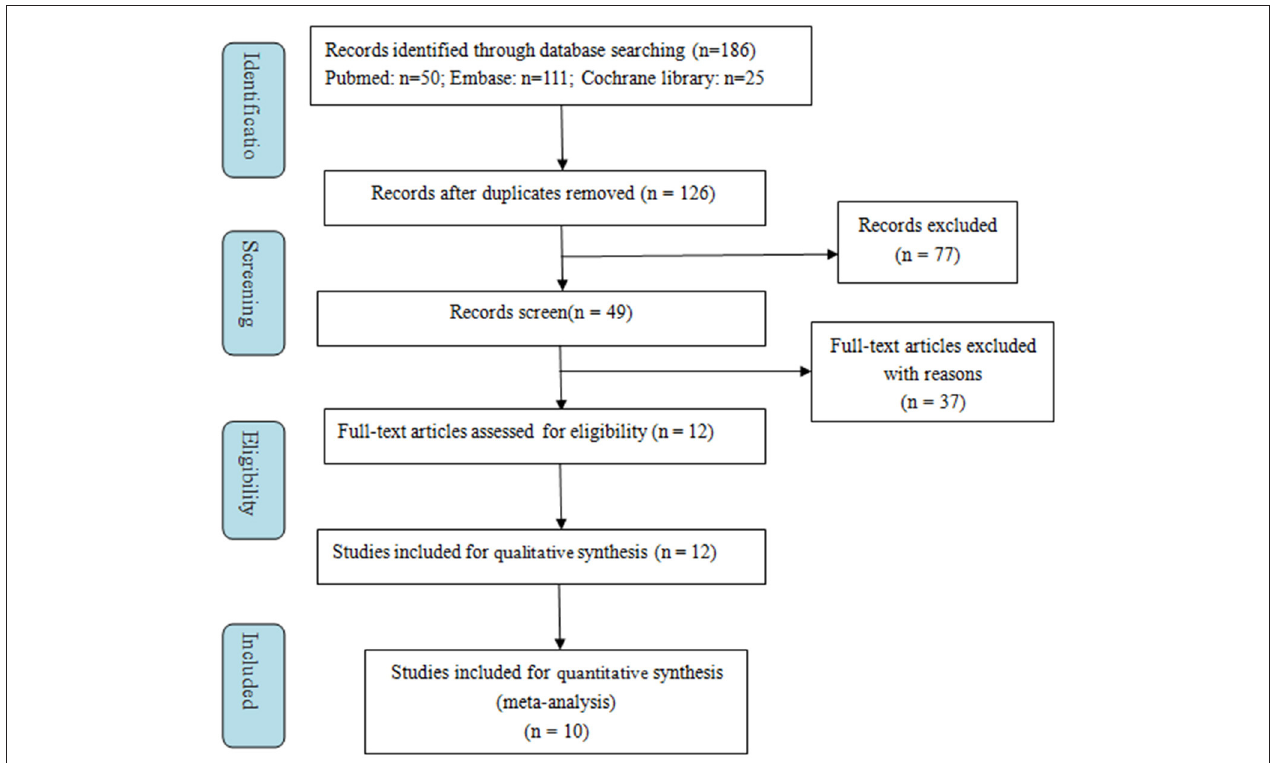
FIGURE 1 | Flowchart indicating the selection process of this meta-analysis.